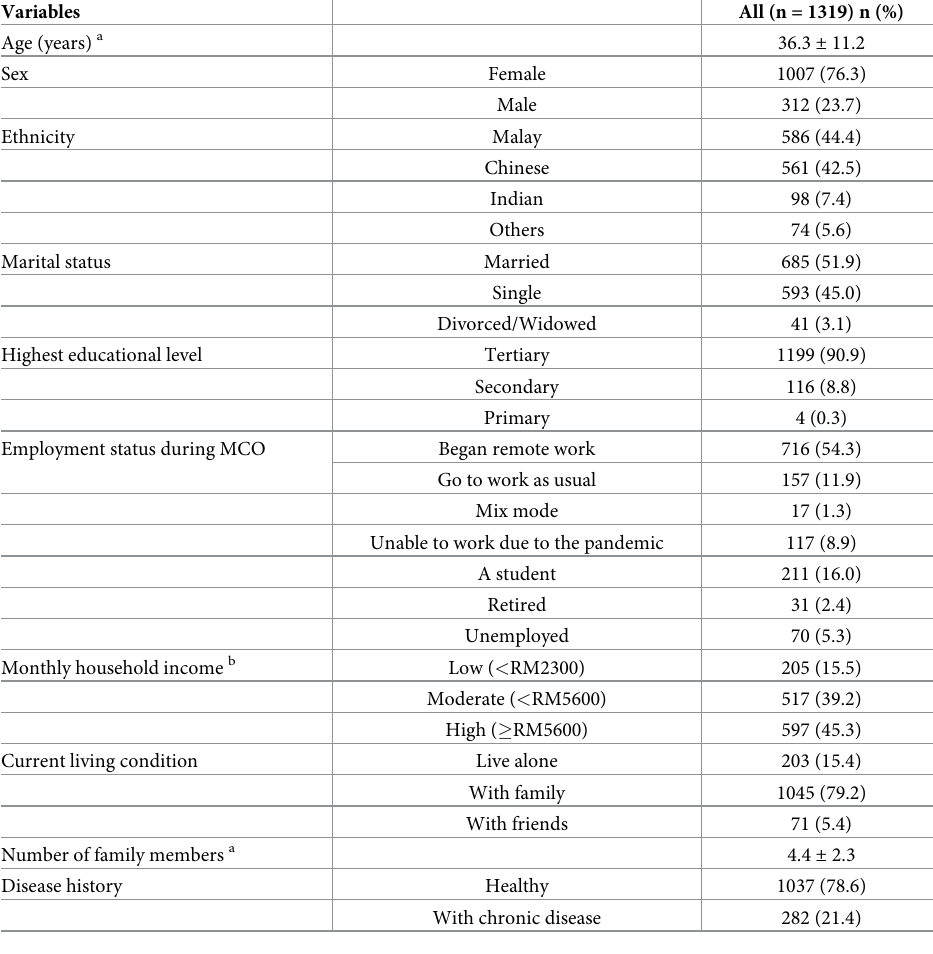
Table 1. Characteristics of the